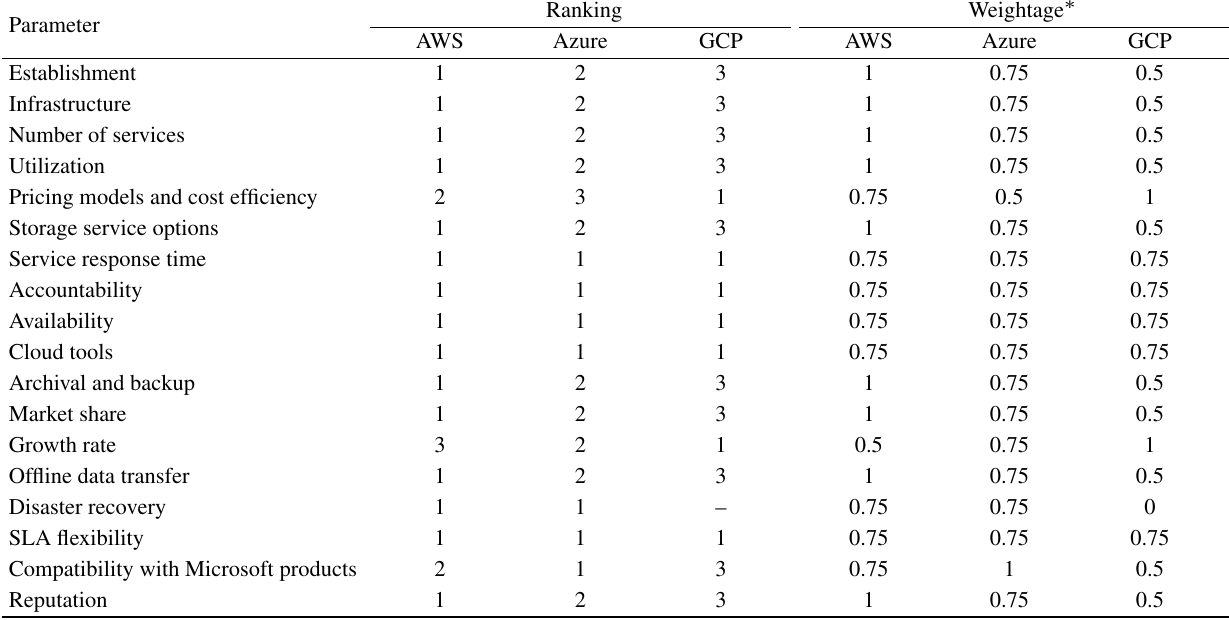
Table 11 Parameter-based ranking and weightage of the CSP selection.